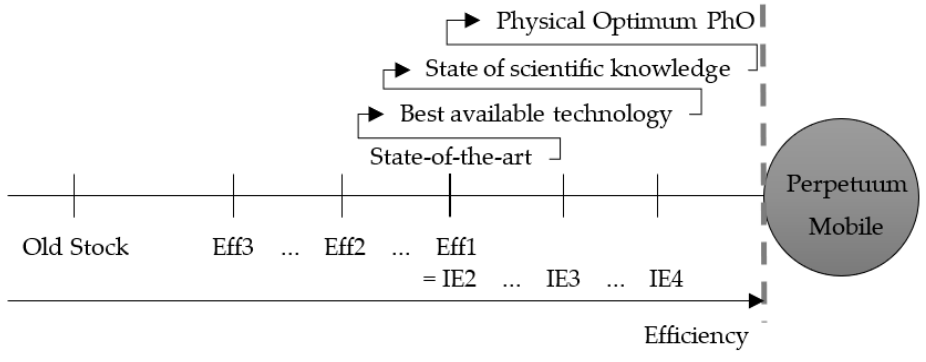
Figure 1. The PhO in comparison to common reference processes [1].